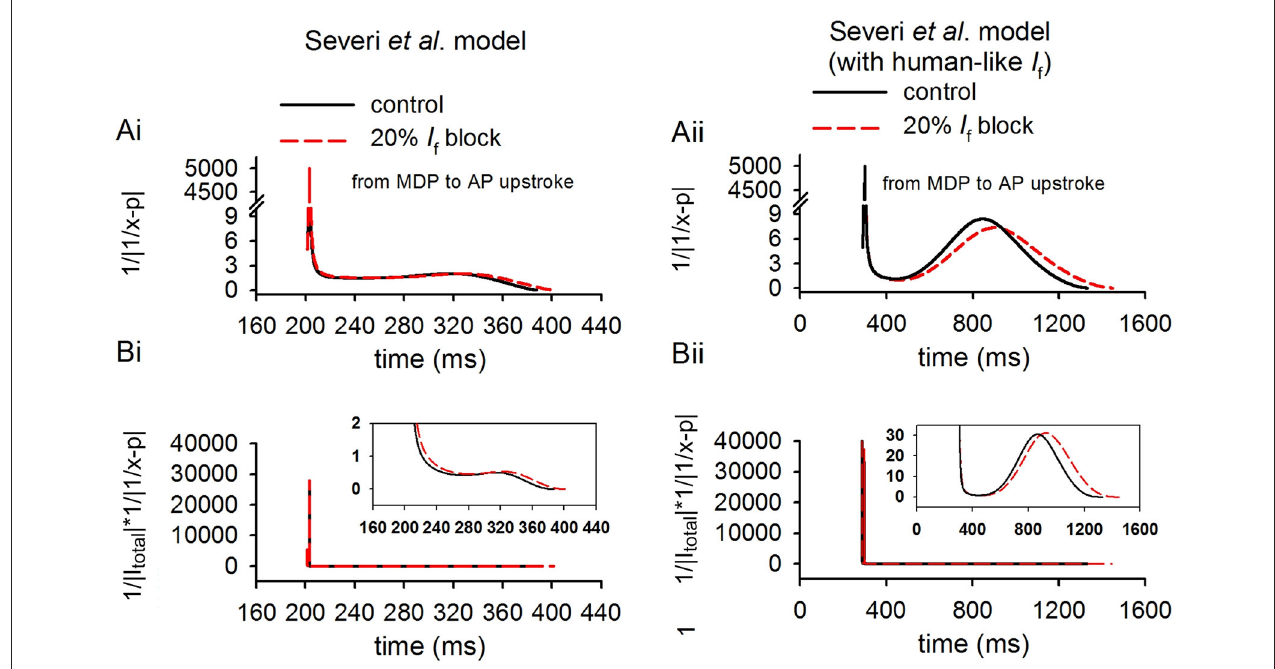
= 0.2, modeling 20% I f reduction).